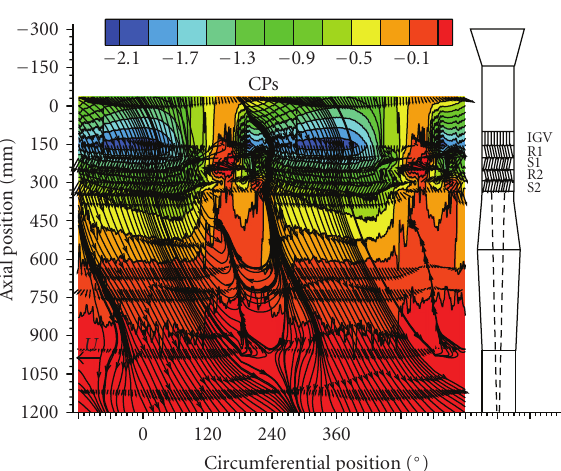
Figure 10: Static pressure coe ffi cient at